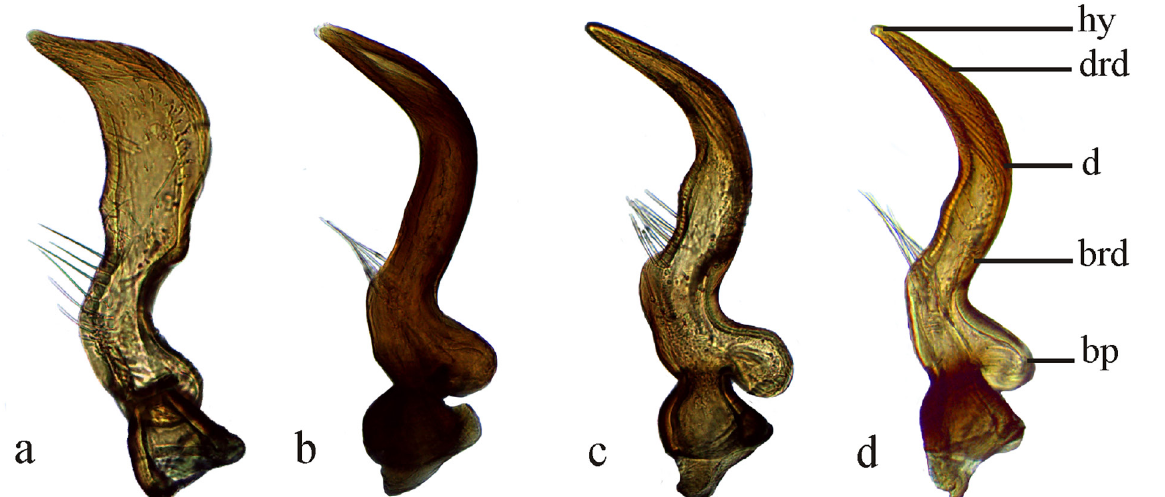
Figure 4. Parameres. a, Nabis ( Austronabis ) argentinus . b, N . ( A .) faminei. c, N . ( A .) paranensis . d, N . ( A .) punctipennis . (bp: paramere base; brd: basal region disc; d: disc; drd: distal region disc; hy: